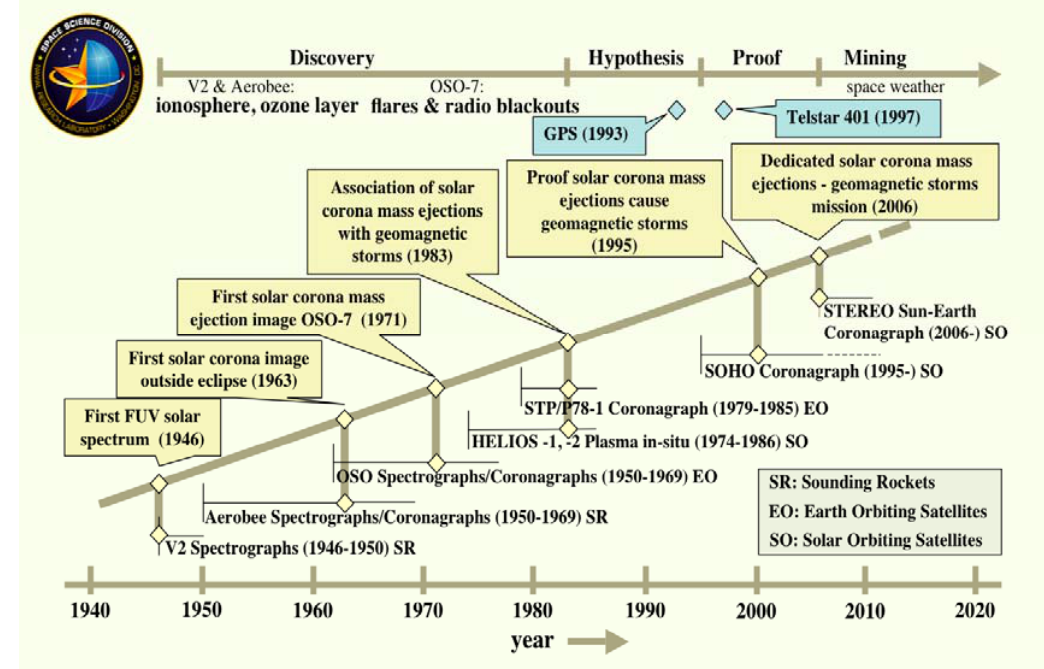
Figure 8. NRL-led space-based solar corona experiments (yellow